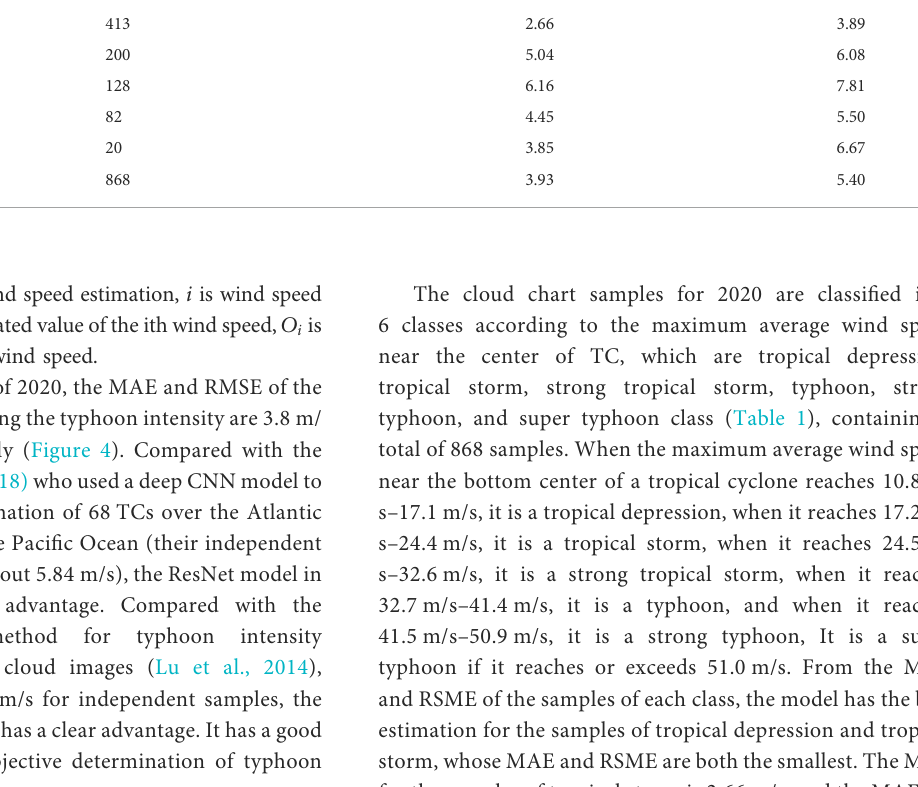
TABLE 1 AI Model analysis of the intensity estimation of the 2020 typhoon cloud samples. Levels Number of samples/pc (MAE) m/s Tropical